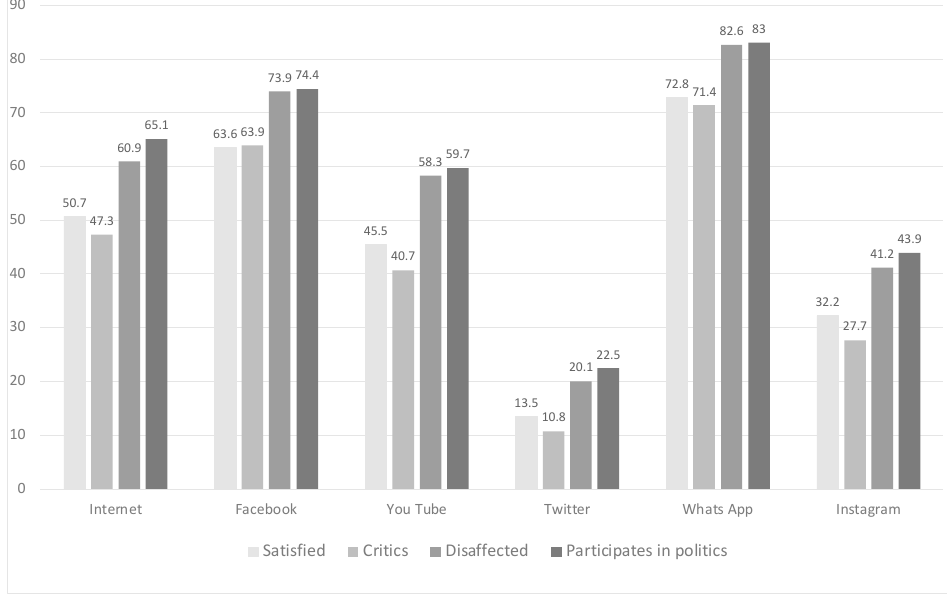
Figure 9. Following of social networks and citizen type. Source: Latinobarometer 2020.